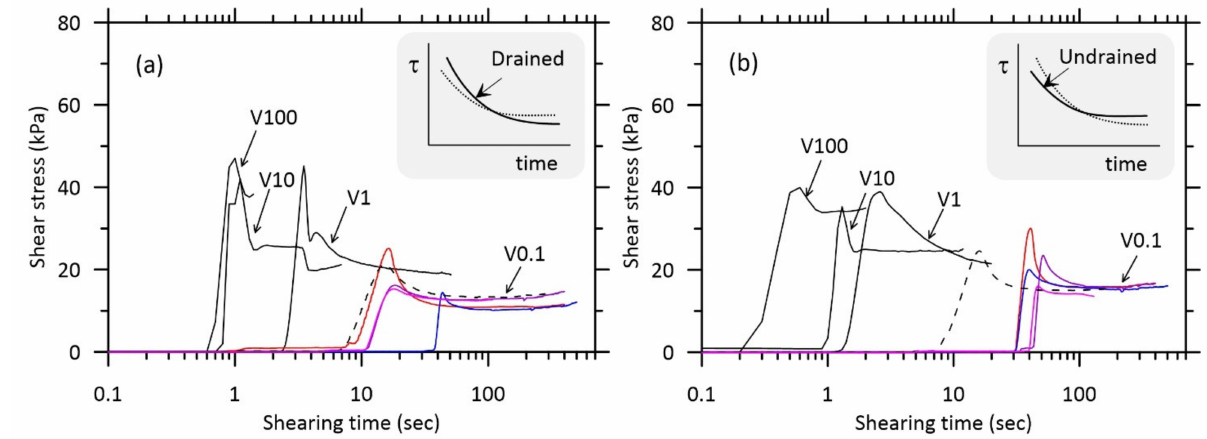
Figure 7. Shear stress and shearing time: ( a ) drained and ( b ) undrained